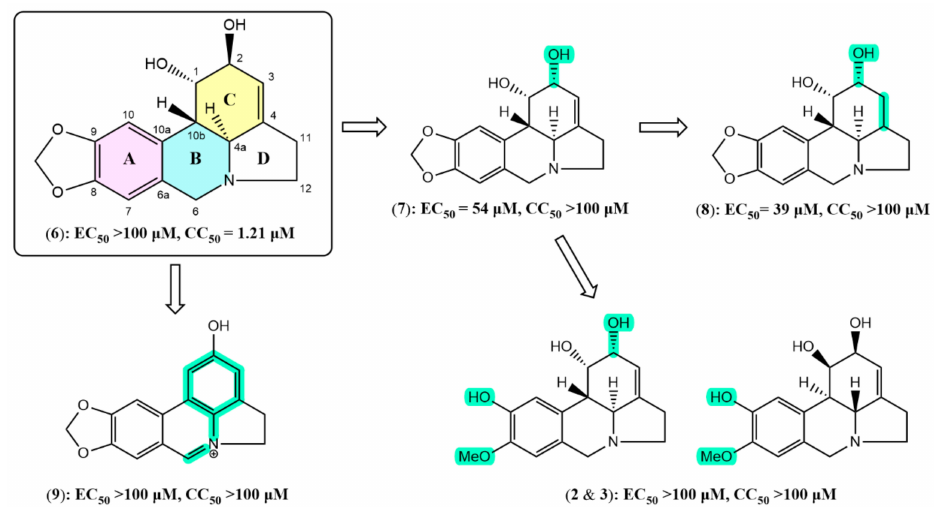
Figure 5. Structure-activity relationship of the lycorine-type alkaloids: lycorine ( 6 ), 2- epi -lycorine ( 7 ), zephyranthine ( 8 ), ungeremine ( 9 ), ( ± )-2- epi -pseudolycorine ( 2 and 3 ). Structural differences compared to lycorine are highlighted in